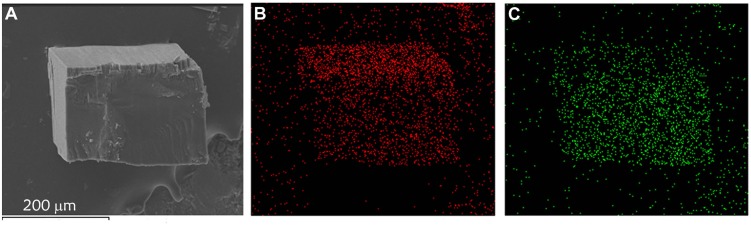
SEM and EDS images of [Zn0.77Cd0.23(pba)2]·2DMA. (A) SEM image of [Zn0.77Cd0.23(pba)2]·2DMA. (B) EDS image of zinc. (C) EDS image of cadmium.